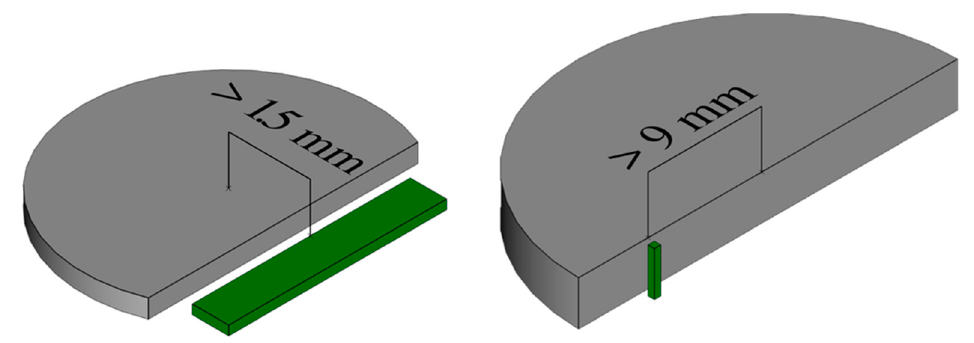
Figure 1. Schematic drawings of the giant magnetoresistance (GMR)—specimen position (green) within small (8 mm diameter, left) and large (30mm diameter, right) HPT-discs.